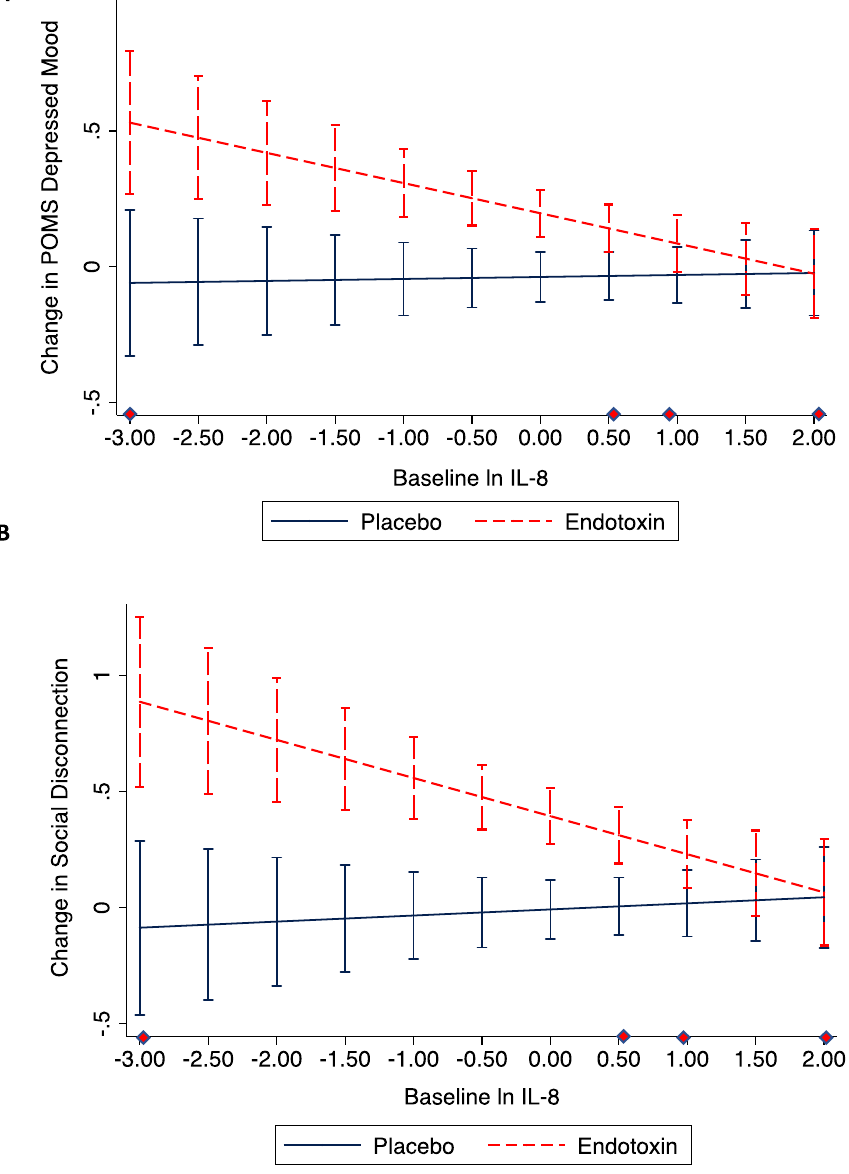
Figure 3. Sensitivity analyses: Endotoxin vs. control group differences in behavioral symptom change across the range of baseline IL-8 concentrations. Across baseline levels of IL-8 in the endotoxin vs. control group, there is a greater increase in depressed mood ( A ) and social disconnection ( B ) up until the threshold of ln IL-8 = 0.90 (antilogarithm 2.5 pg/mL) ( A ) and ln IL-8 = 1.05 (antilogarithm 2.9 pg/mL) ( B ), which roughly corresponds with the cut-off for the upper IL-8 quartile (2.7 pg/mL). Error bars are 95% Confidence Intervals. Diamond symbols demarcate baseline IL-8